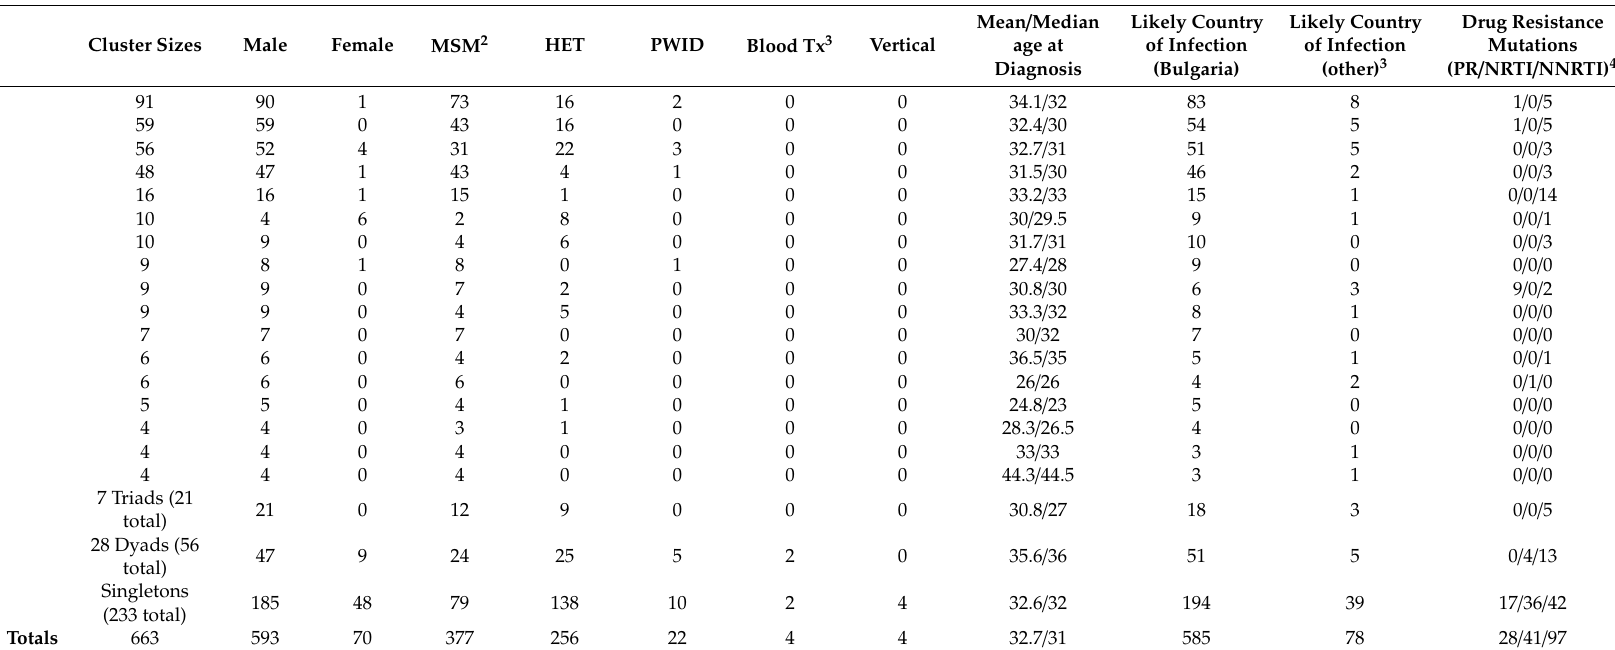
Table 2. Characteristics of HIV-1 subtype B clusters and unclustered persons in Bulgaria, 1988–2018, using a genetic distance cuto ff of 1.5% 1 . Cluster